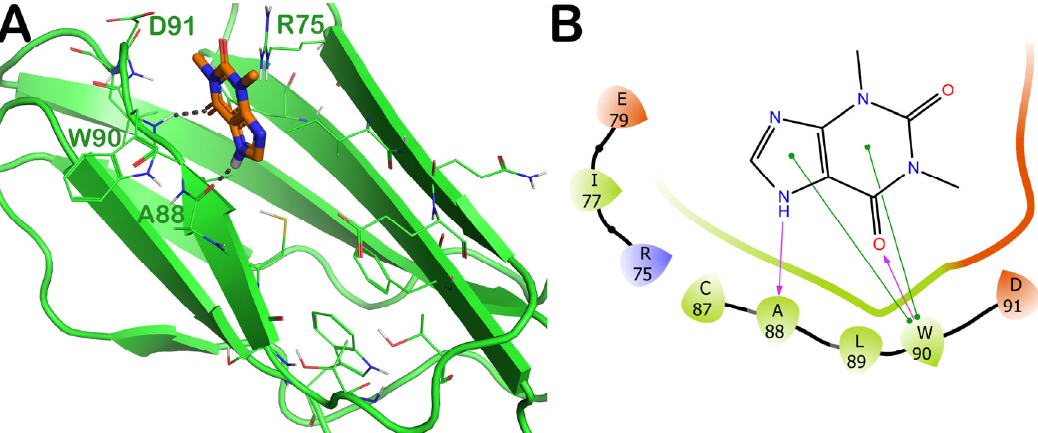
Figure 11. ( A ) Docking output of compound ZINC000018043251 (orange sticks) within the surface of the irisin monomer (PDB ID 4LSD, green cartoon) involved in the dimerization process. The key interacting residues are represented by lines. The H bonds are depicted as dotted lines. Non-polar hydrogen atoms were removed for the sake of clarity. ( B ) A 2D representation of the contacts established by ZINC000018043251 within the irisin monomer interface. Images were prepared using PyMOL and the Ligand-Interaction Diagram application implemented in Maestro. Table 3. Predicted binding free energies ( ∆ G bind ) from the MM-GBSA calculations and the energy components of the best-ranked